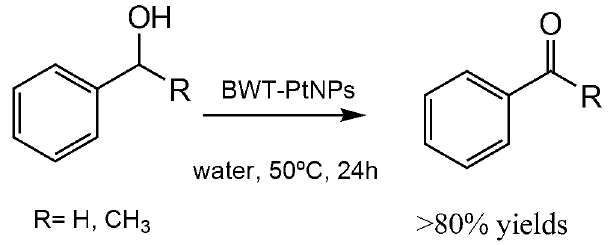
Figure 14. Oxidation of phenylalcohols by BWT-PtNPs.